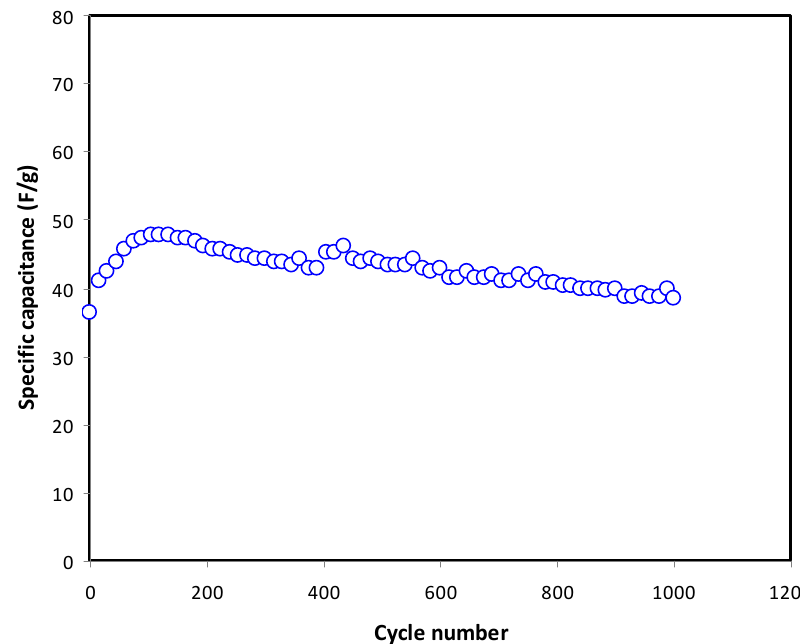
Figure 10. Satiability in specific capacitance value of the fabricated EDLC up to 1000 cycles at 0.5 mA/cm 2 .